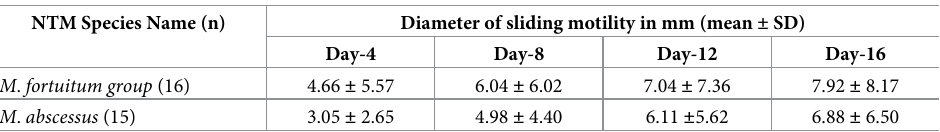
Table 6. Test results of sliding